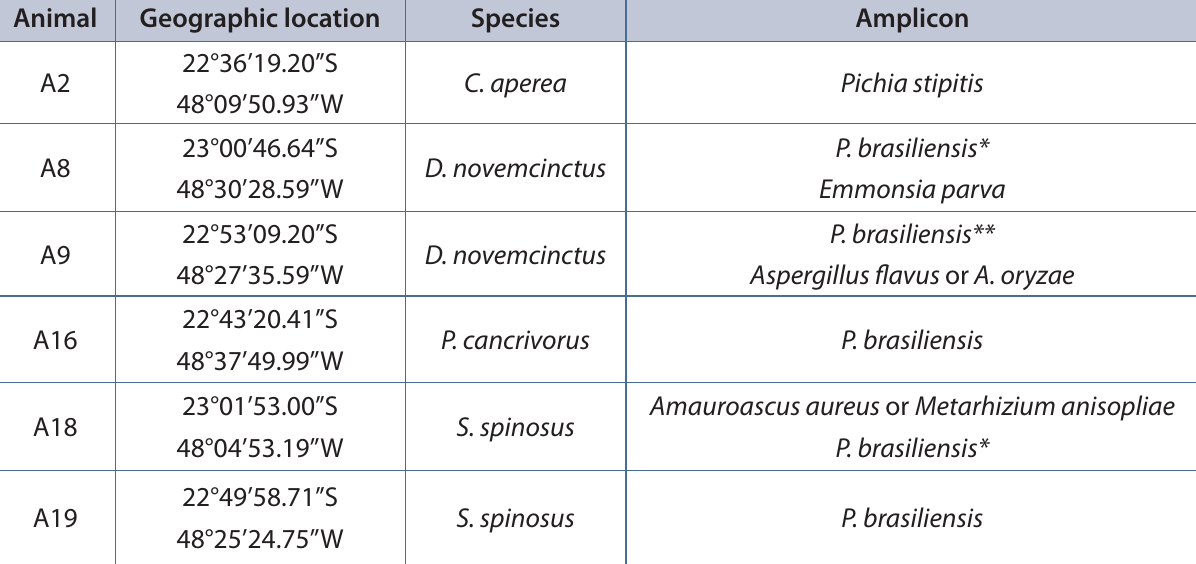
Table 1. Geographic distribution of animals that revealed positive DNA amplification for fungi in PCR reaction